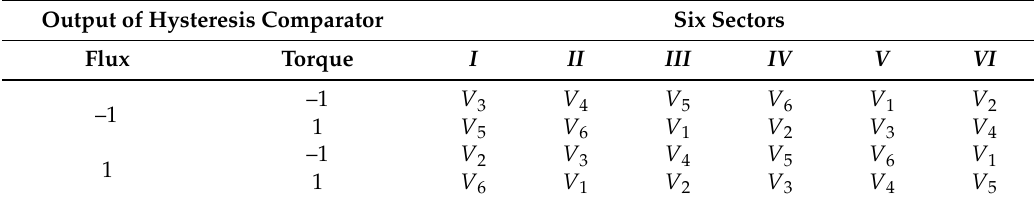
Table 2. Voltage vector switch table (generating mode). Output of Hysteresis